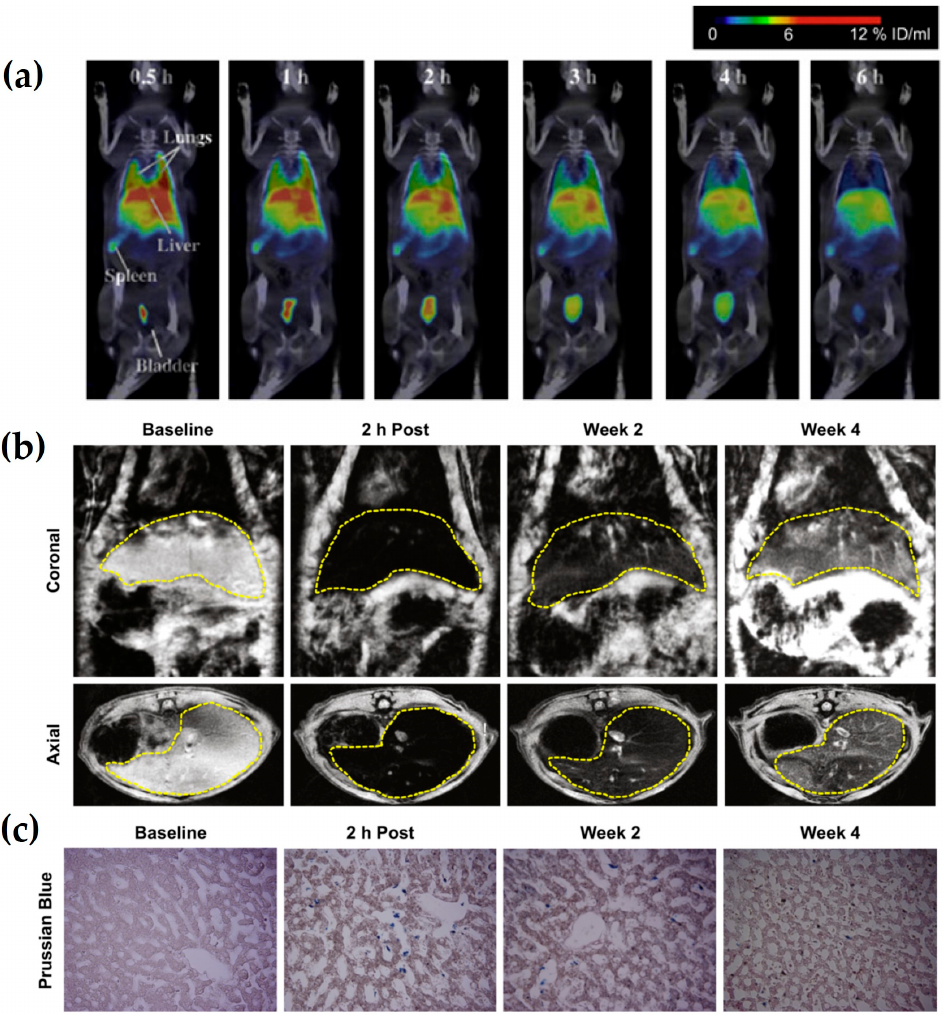
Figure 3. ( a ) Representative SPECT/CT images of a rat at 0.5–6.0 h after injection of 99m Tc-CS–IONs; ( b ) T 2 MR images of rat livers; and ( c ) Prussian blue staining for CS-IONs in the liver before and at 2 h, 2 weeks, and 4 weeks after injection of CS-IONs (Reprinted from [38], with permission from Elsevier).